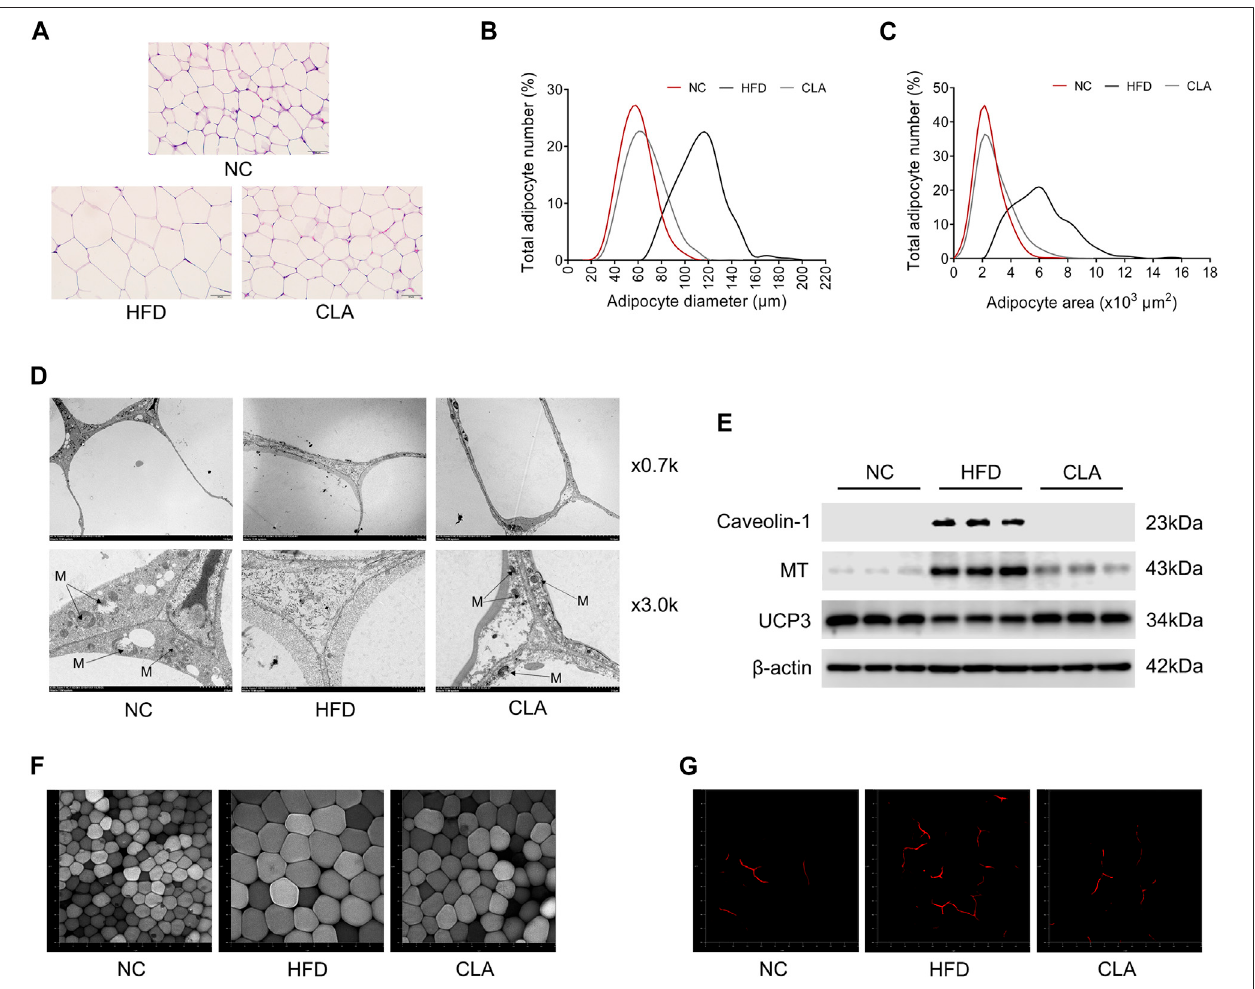
FIGURE 6| Effect of CLA on the pWAT of mice induced with a HFD for 16 w. (A) Representative H and Estainingof pWAT sections. Original magni fi cation, × 400. Scale bar, 50 μ m. (B) Adipocyte diameter and (C) Adipocyte area are shown ( n (cid:2) 6). (D) Representative transmission electronic microscopy images of pWAT. M, mitochondria; original magni fi cation, × 0.7 k and × 3.0 k. Scale bar, 10.0 μ m. (E) Detection of Caveolin-1, MT and UCP3 by Western blotting ( n (cid:2) 3 in each group). (F) Representative fl uorescence characterization of LipidTOX for detection of the adipocytes. (G) Representative fl uorescence characterization of PECAM-1 for the detection of angiogenesis. Original magni fi cation, × 200. Scale bar, 50 μ m.